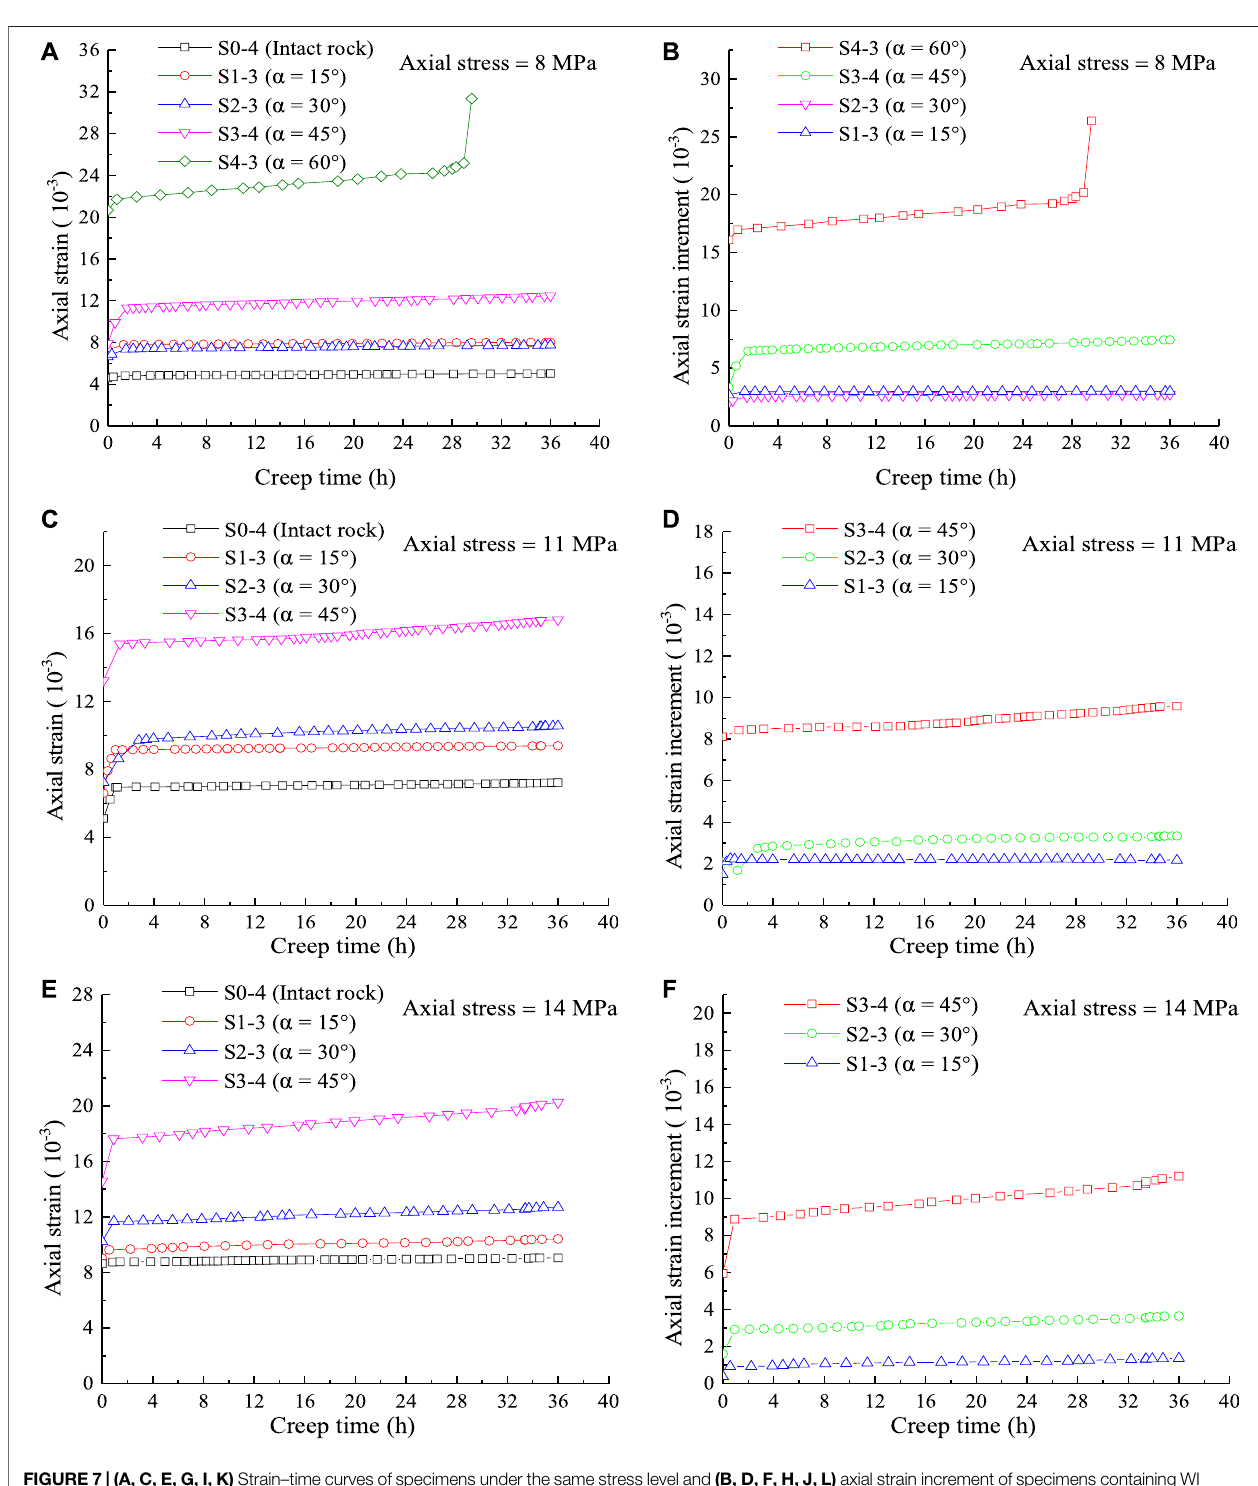
FIGURE 7 | (A, C, E, G, I, K) Strain – time curves of specimens under the same stress level and (B, D, F, H, J, L) axial strain increment of specimens containing WI relative to intact specimens.